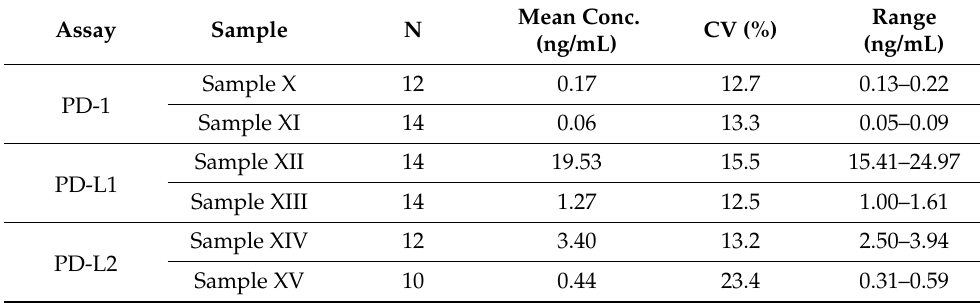
Table 2. Results for inter-assay imprecision experiments.